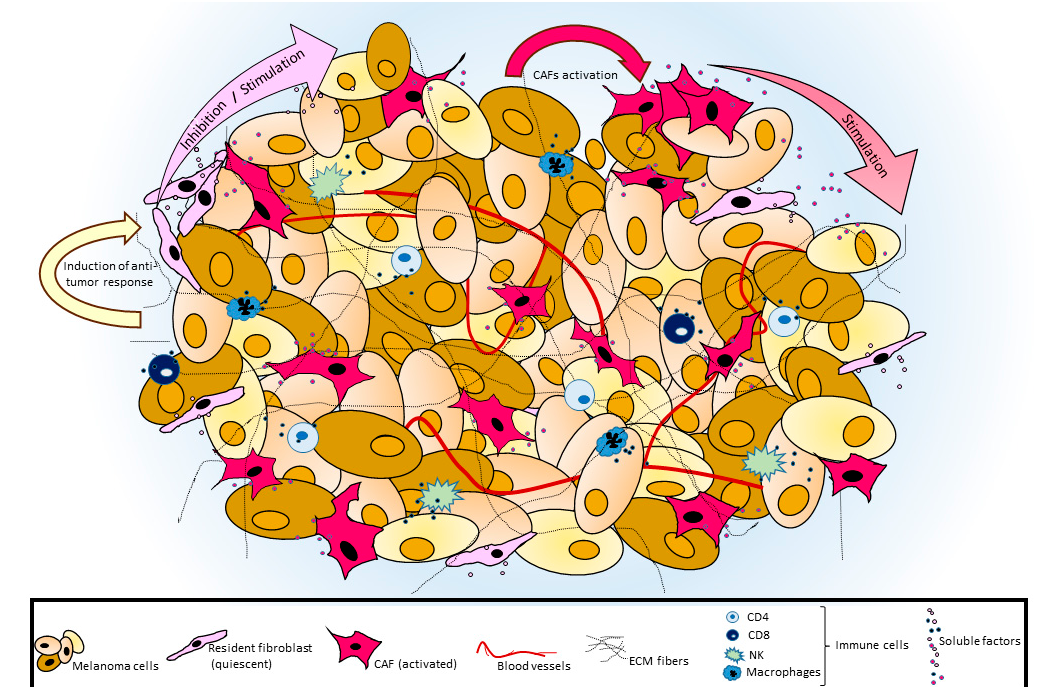
Figure 1. Schematic representation of tumor–stroma cross-talk. In melanoma, tumor cells share their microenvironment with MAFs, immune cells and blood vessels. Resident fibroblasts might oppose an early anti-tumor activity or facilitate tumor development, whereas, during disease progression, activated MAFs gradually acquire a marked pro-tumorigenic phenotype. An intense bi-directional exchange of soluble factors between melanoma and surrounding cells significantly modifies in MAFs several intracellular signaling pathways including oncogenic pathways. Extracellular matrix supports tumor architecture and influences various signal transduction pathways in both tumor and associated cells.